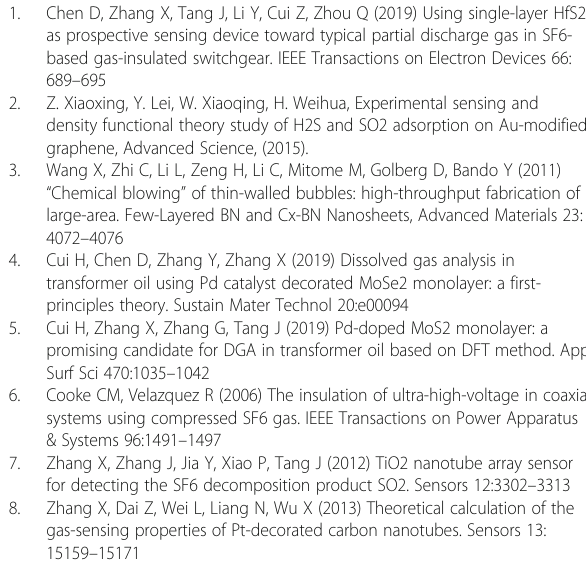
Additional file 1: Figure S1 . Geometries of (a) SO 2 , (b) SOF 2 , and (c) SO 2 F 2 . The black values are bond length while the orange values are bond